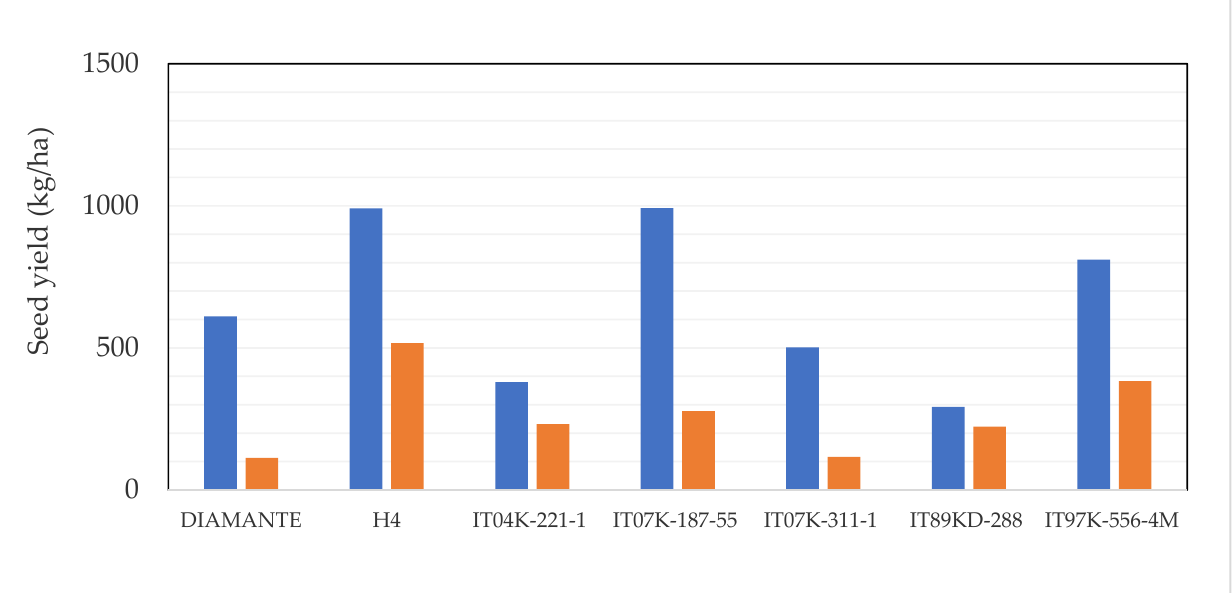
Figure 3. Mean values of seed yield for genotypes treated (blue) and untreated (orange). Table 3. Eigenvectors computed by PCA.